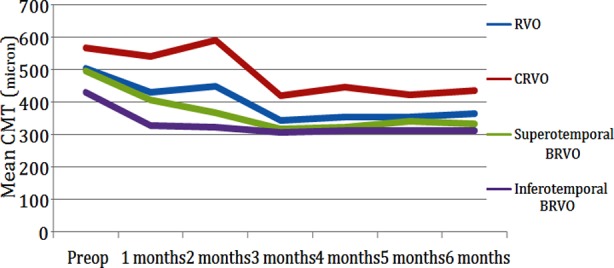
Mean CMT before and after treatment.Abbreviations: CMT, Central foveal retinal thickness; RVO, retinal vein occlusion; CRVO, central retinal vein occlusion; BRVO, branch retinal vein occlusion.